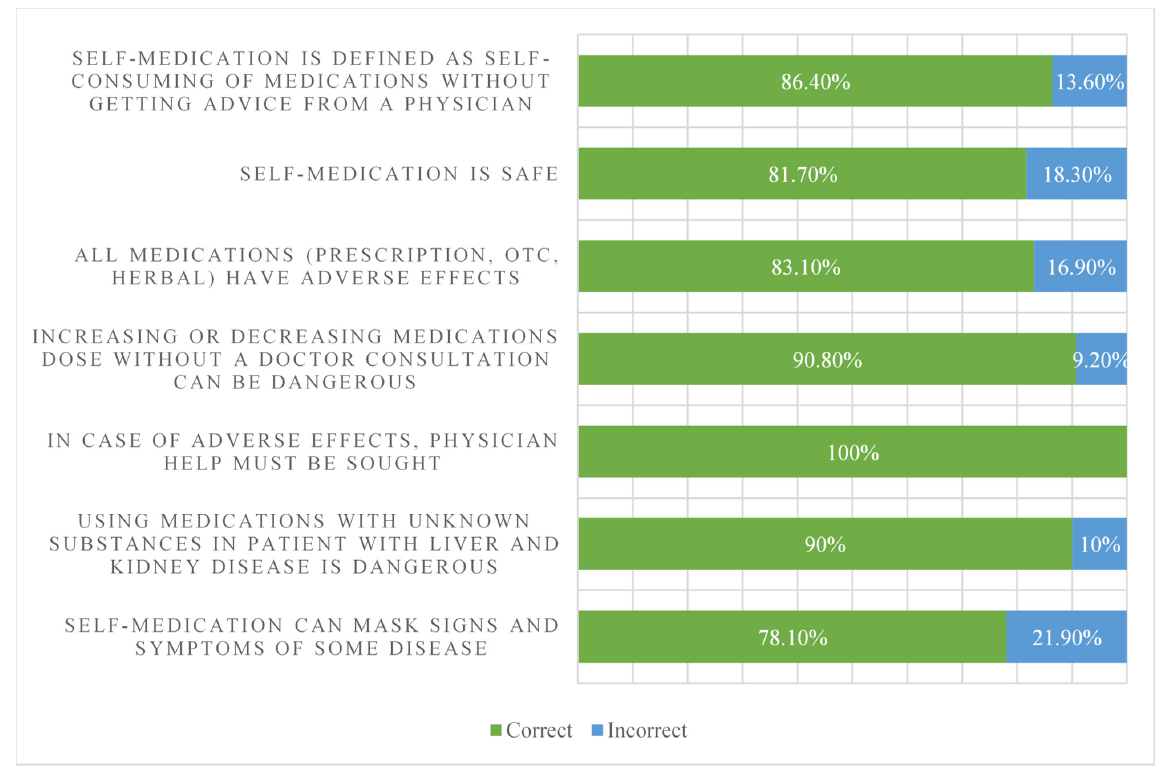
Figure 1. Participants’ knowledge related to self-medication. NB: N = 1173. Table 2. Comparison of self-medication-related knowledge and attitude scores among selected